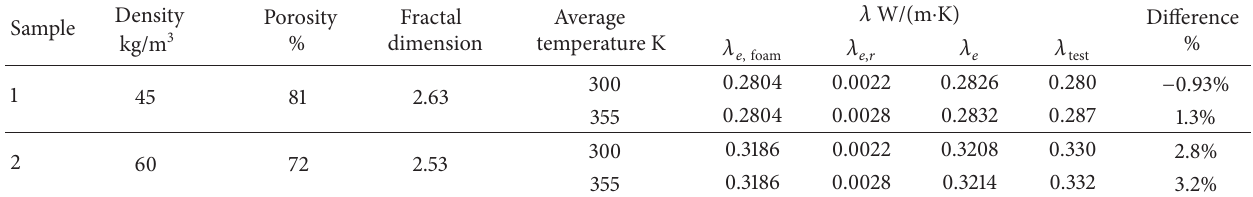
Table 1: The comparative table between results of calculation and